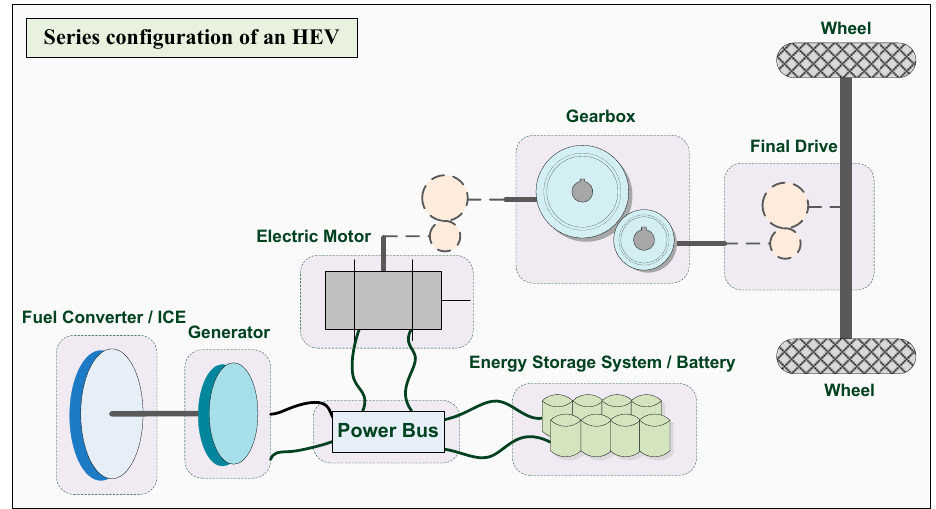
Figure 1. Series configuration of a hybrid electric vehicle (HEV).